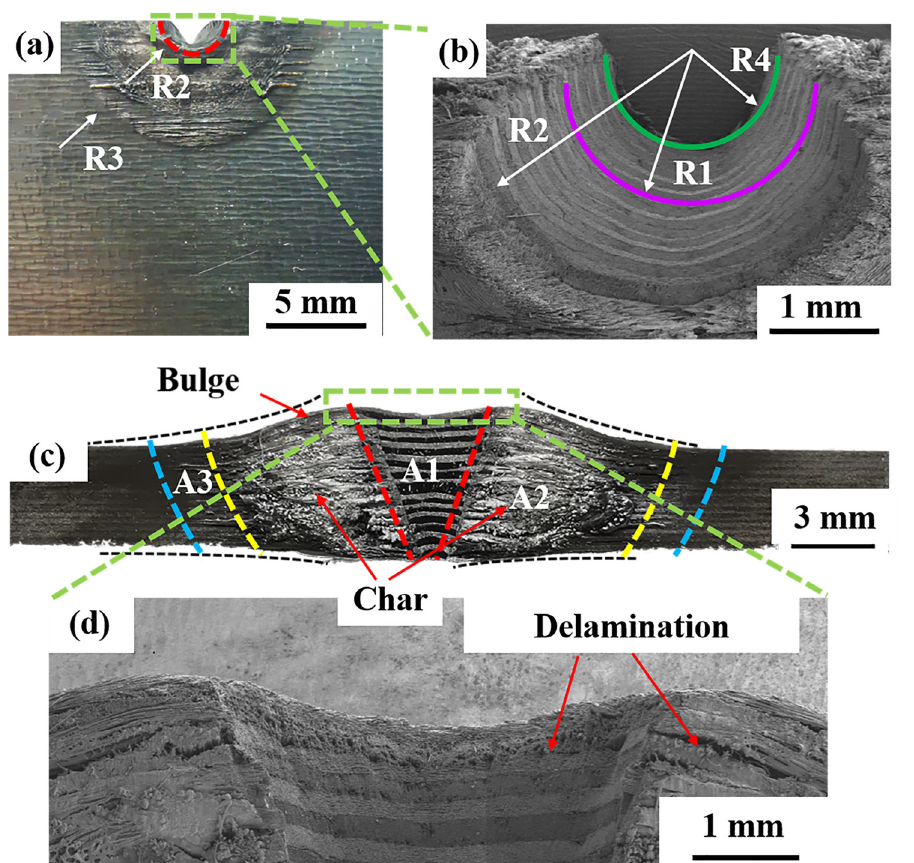
Figure 4. Morphology of the CF/PAEK surface after the laser ablation test: ( a , b ) front surface; ( c , d ) cross section.